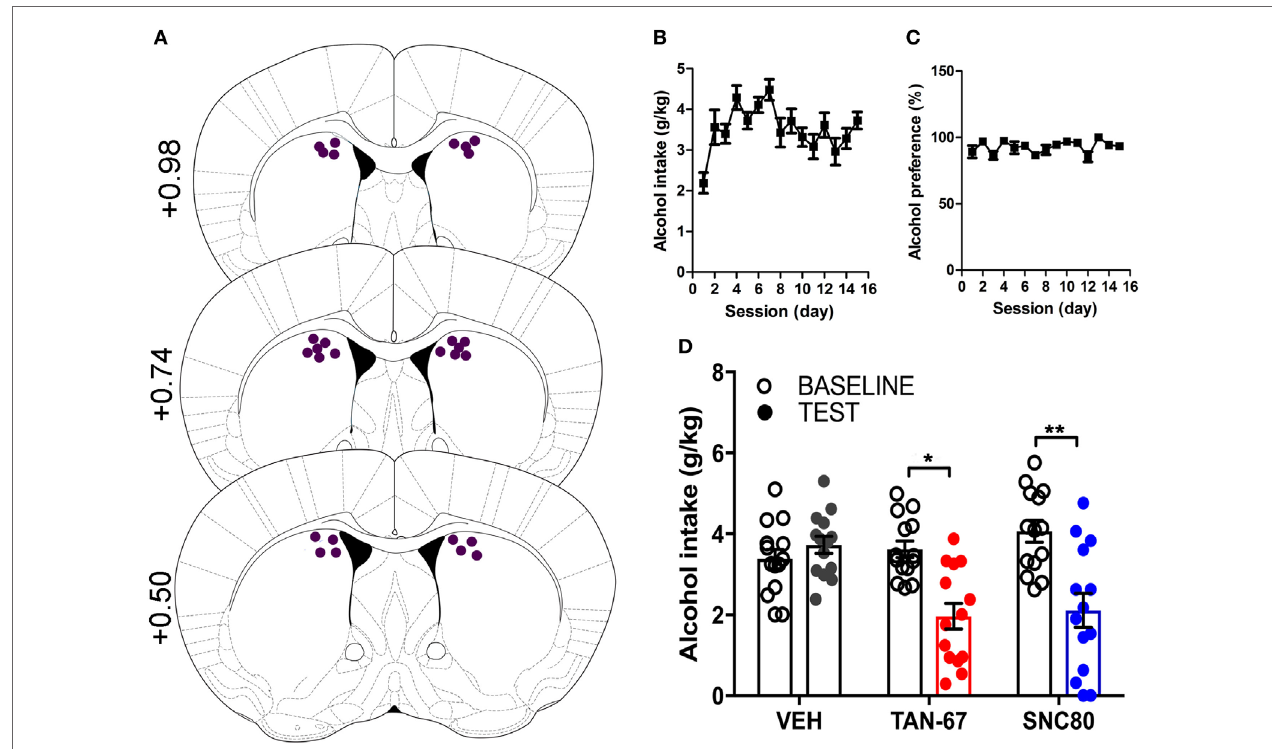
FigUre 5 | Genetic knockout (KO) of β -arrestin-2 reveals critical role of G i/o signaling in reducing alcohol intake via dorsal striatal delta-opioid receptor activation. Cannula placement was verified for all animals included in behavioral analysis (a) . C57BL/6 male, β -arrestin-2 KO mice ( n = 12) were trained to consume 10% alcohol over the course of 3 weeks, during which they increased their alcohol intake (B) and alcohol preference (c) . Vehicle saline (0.9%) infusion did not change alcohol intake, but both TAN-67 and SNC80 (10 µM) significantly decreased alcohol intake (D) . Significance by repeated measures, multiple comparisons (Tukey) by two-way ANOVA, * p < 0.05 and ** p <